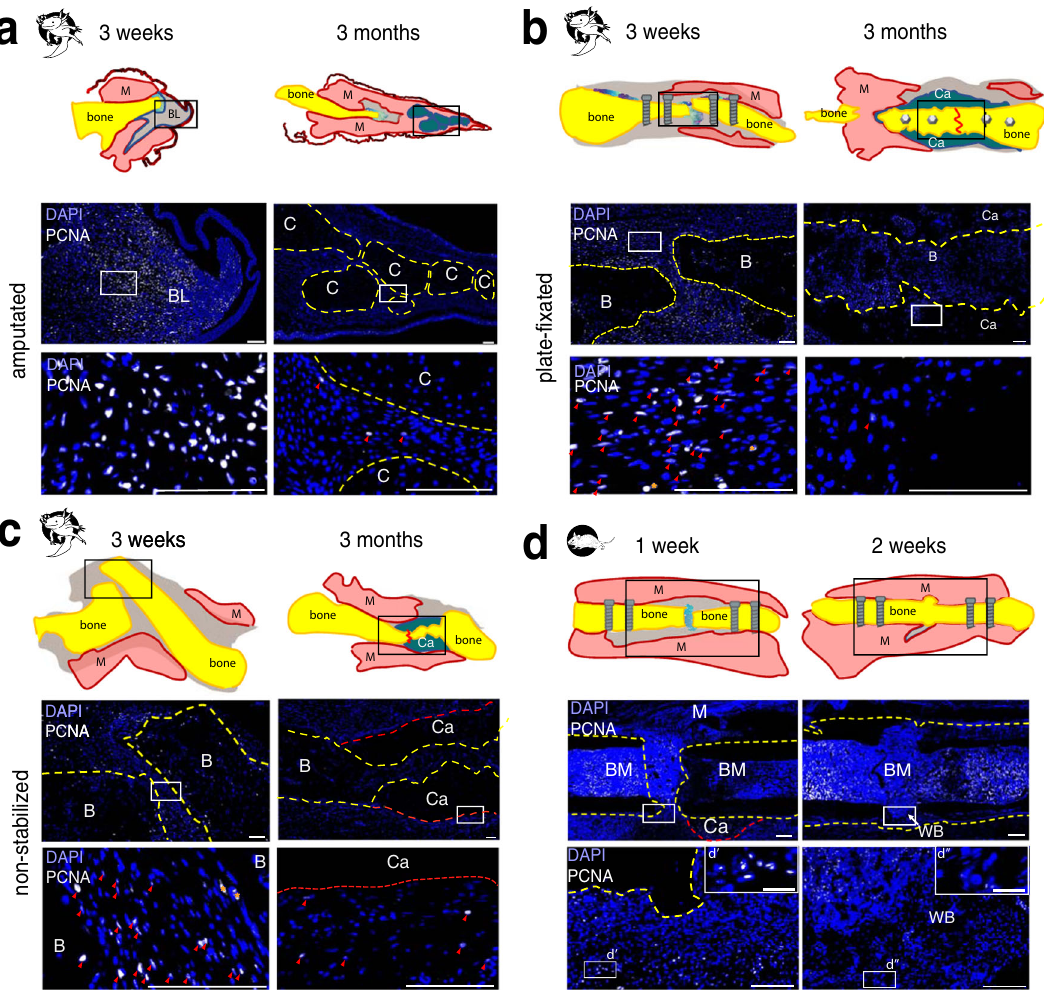
Fig. 5 PCNA immunostaining showed a decreased proliferation in amputated limbs and fractured bones at 3 months post-surgery. Representative samples of axolotl upper hind limbs stained with anti-PCNA (white) and DAPI (blue) 3 weeks and 3 months post-surgery in axolotl amputated limbs ( a ), in plate- fi xated fractures ( b ), and in fractures without fi xator ( c ). Note high number of PCNA + cells in 3 weeks axolotl samples. Only a few PCNA + cells can be observed in 3 months samples. Here, proliferating cells are mostly observed in the soft tissues. d Mouse fracture samples show many PCNA + cells in the proximity to injury site at 1 week post-fracture. At 2 weeks post-fracture, PCNA + cells are retained in the bone marrow, and not in the newly formed bone. d ’ and d ” show enlarged boxed areas. Scale bars 200 µm, 50 µm in d ’ and d ” . Yellow dashed line - bone, red dashed line - callus, red line on sketches – former fracture site, BM – bone marrow, M – muscle, C – cartilage, Ca – callus, BL – blastema, B – bone, red arrows show PCNA +